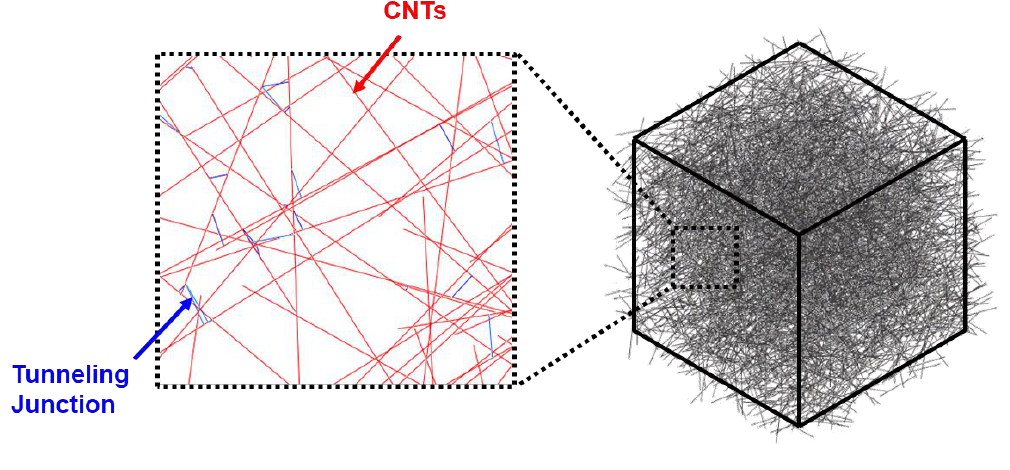
Figure 5. 3D resistance network model.